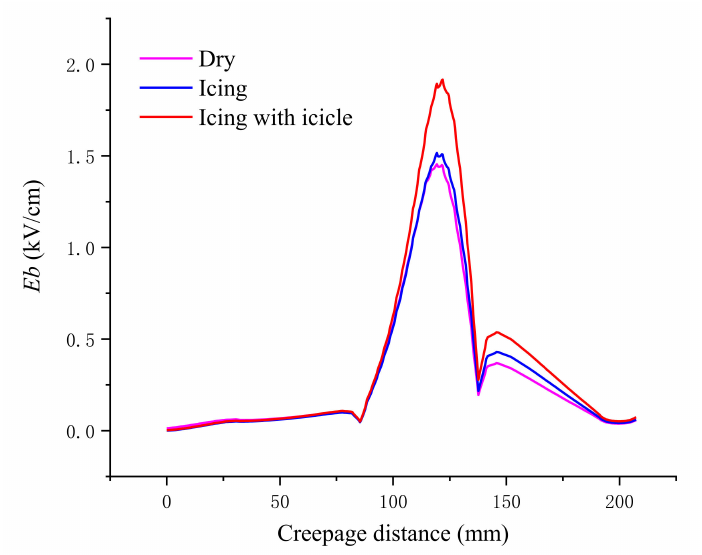
Figure 7. Electric field distribution of the pin electrode.